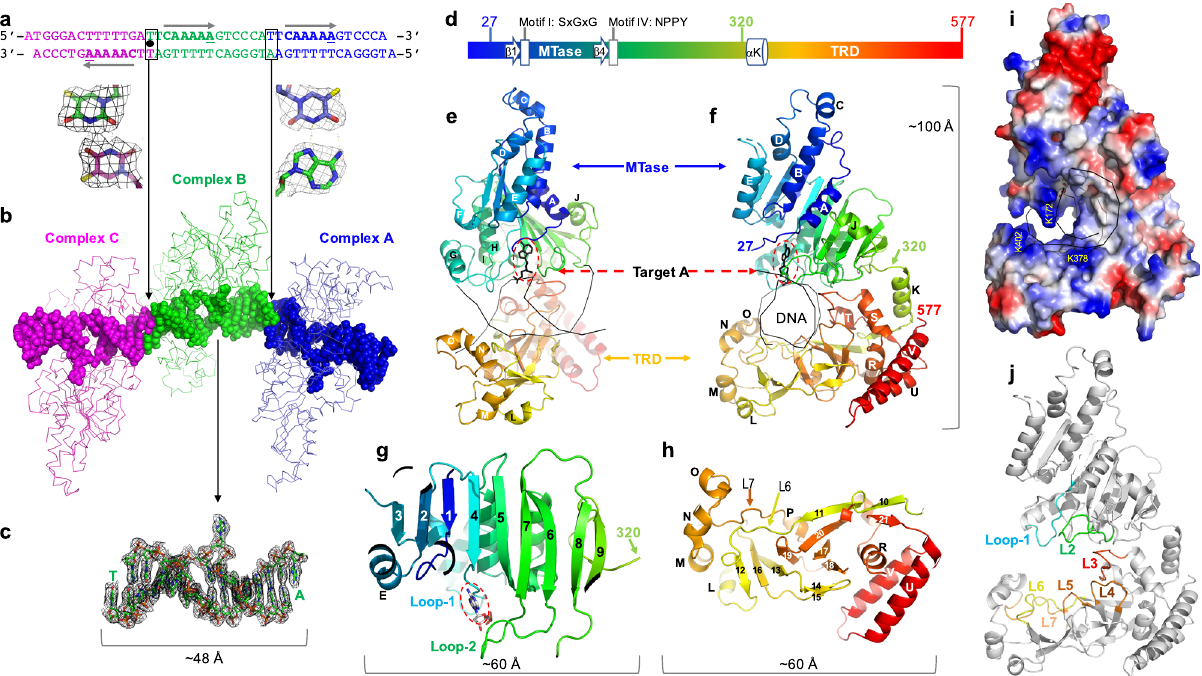
Fig. 2 Structure of CamA-DNA complex. a DNA oligos used for co-crystallization are connected by two different joints in the crystals (T:T mismatch linking complexes B and C, and T:A in a Hoogsteen base pair linking complexes A and B). The CamA recognition sites (CAAAA A ) are indicated by arrows from 5 ′ to 3 ′ , and the three target adenines are each separated by ~1.5 turns of DNA (14 bp). b Three CamA-DNA complexes were formed in the crystallographic asymmetric unit. c Omit electron density map (contoured at 4.5 σ above the mean) for the DNA molecule of complex B. The base- fl ipped adenine is visible. d Schematic illustration of CamA with relative locations of motifs I and IV and TRD. Residue 320 before α K indicates the linker point between the two domains. e , f Two orthogonal views of CamA, colored in spectrum from blue (N-terminus) to red (C-terminus). g The N-terminal catalytic domain folds into a nine-stranded sheet. Loop-1 follows strand β 4 and loop-2 is between strands β 6 and β 7. h Antiparallel β -structure of C-terminal TRD. i Electrostatic surface of CamA with blue for positive and red for negative charges. j Seven loops (L1 – L7) line the basic surface of the cleft for DNA